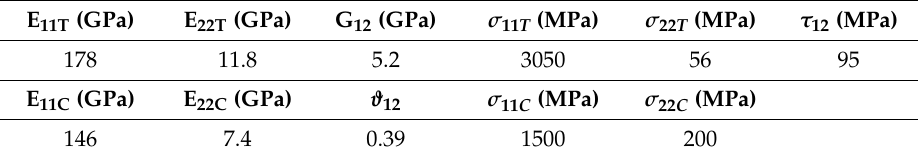
Table 1. Stiffness and Strength properties of the M21E/IMA carbon fibre/epoxy system. E 11T (GPa) E 22T